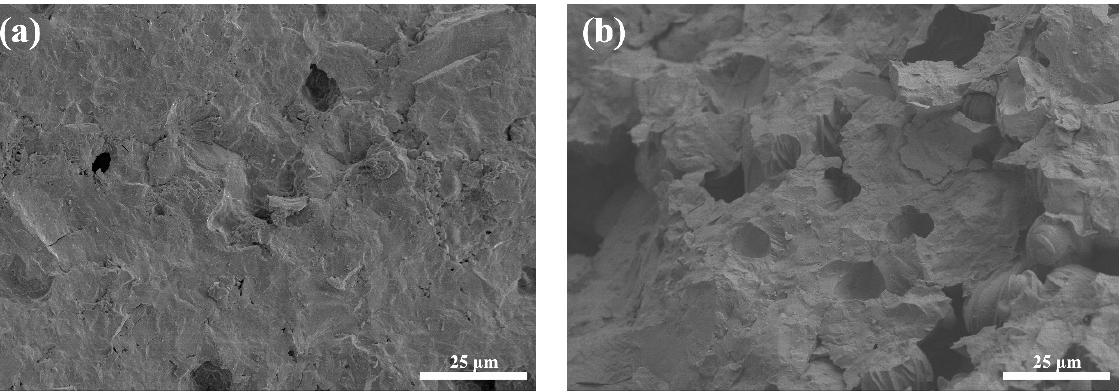
Figure 4. Morphology of BOF slag before and after SiC foaming. ( a ) Reconstructed BOF slag; ( b ) Porous reconstructed BOF slag.